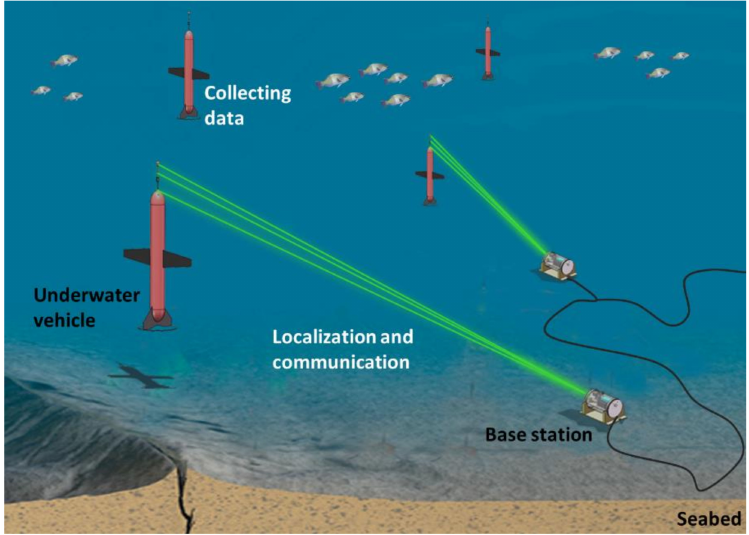
Figure 1. Illustration of the underwater vehicle localization and communication scheme based on laser